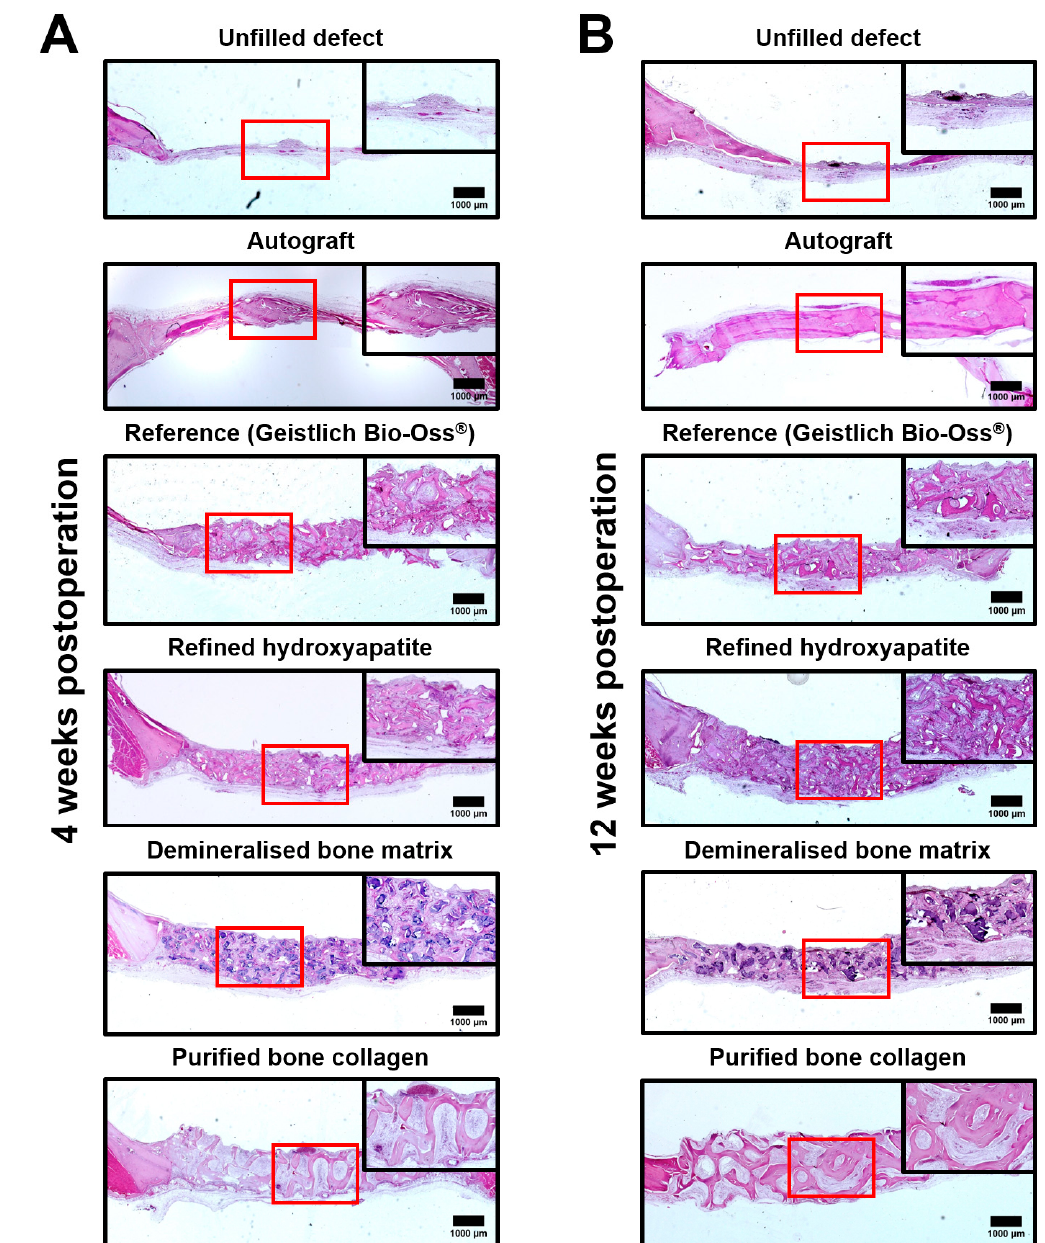
Figure 2. Representative hematoxylin and eosin-stained sections of rat calvarial bone tissues demonstrating filling of the critical-sized (8 mm diameter) rat calvarial defect upon the implantation of bovine-derived HA, DBM, and COLL in a ( A ) short- and ( B ) long-term. Close-ups (red squares demarcating the inserts) show areas with ongoing repair. Unfilled defect, autograft, and Geistlich Bio-Oss® represent a negative control, positive control, and reference product, respectively. HA—refined